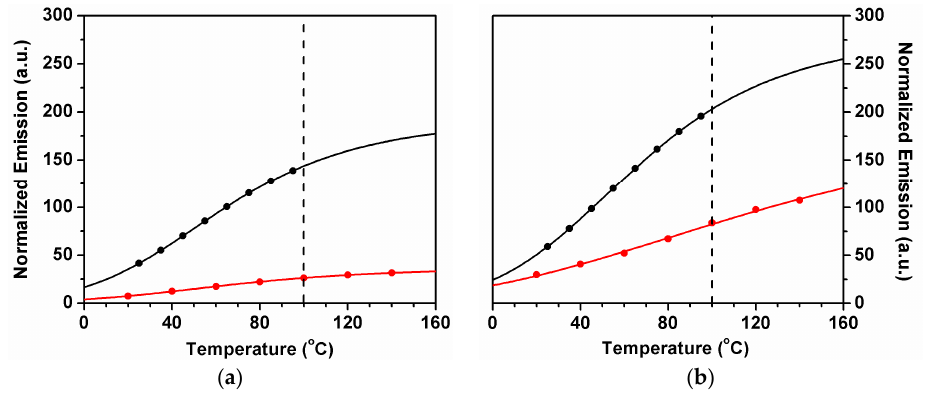
Figure 4. I DF /I PF versus temperature for 12 C 70 ( a ) and 13 C 70 ( b ) in DHOC4 (red) and PS (black). The lines correspond to Equation (2).